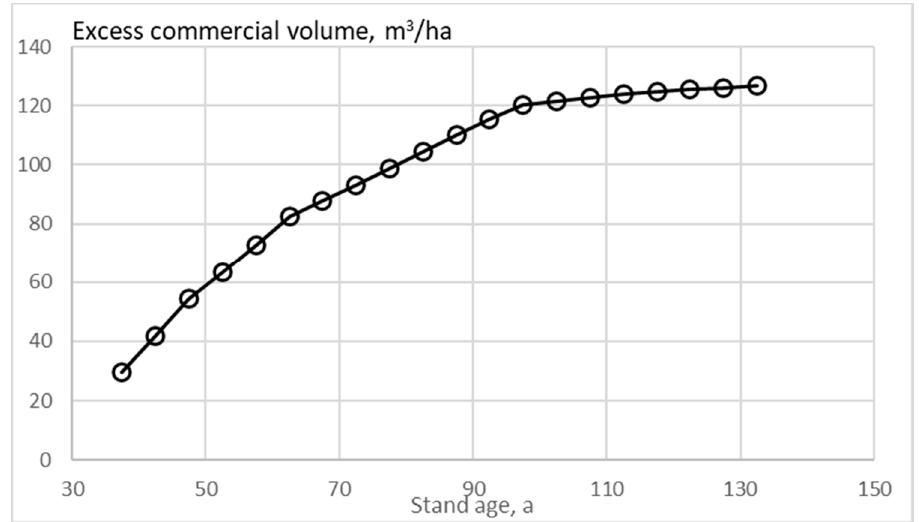
Figure 15. Excess commercial volume per hectare with thinnings from below, in comparison to the treatment schedule corresponding the greatest expected value of capital return rate.